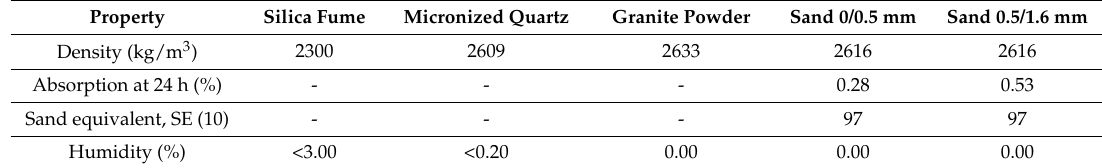
Table 2. Materials properties.